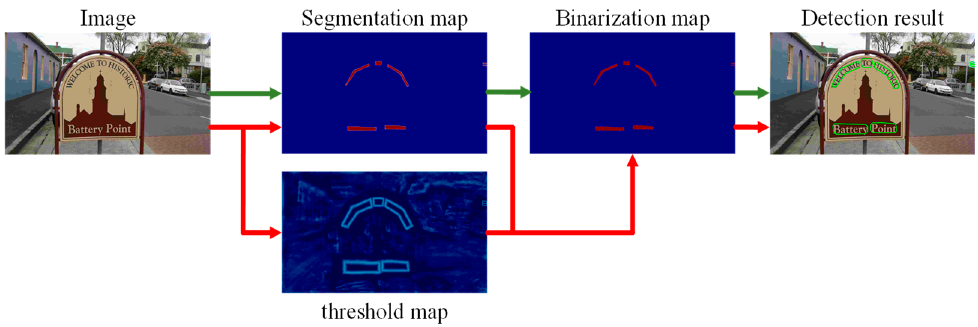
Figure 4. Structure diagram of differentiable binarization.